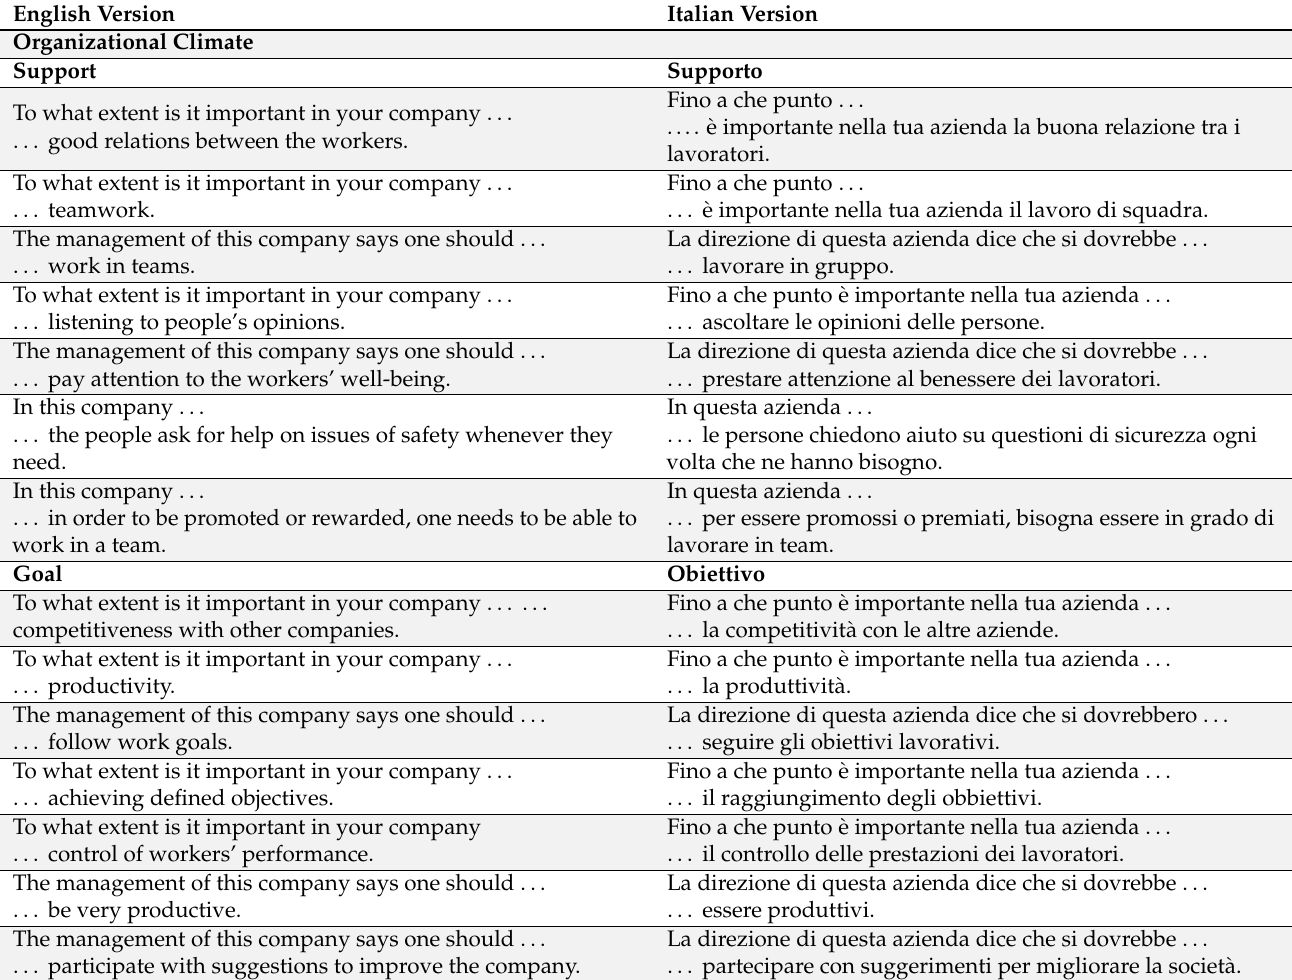
Table A1. List of items in English and Italian